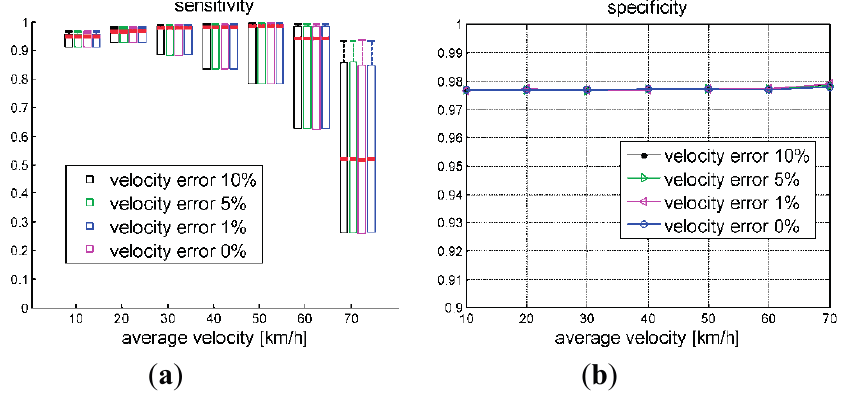
Figure 12. Sensitivity and specificity of true inliers detection vs. vehicle velocity. Outlier percentage is set to 50%, velocity error varies from 0 to